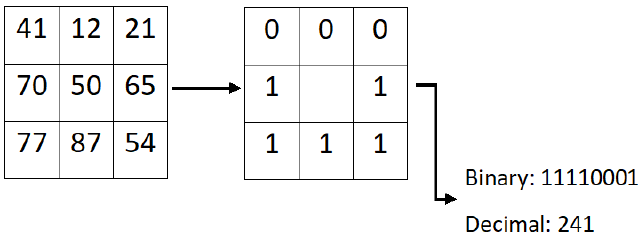
Figure 12. LBP operation.